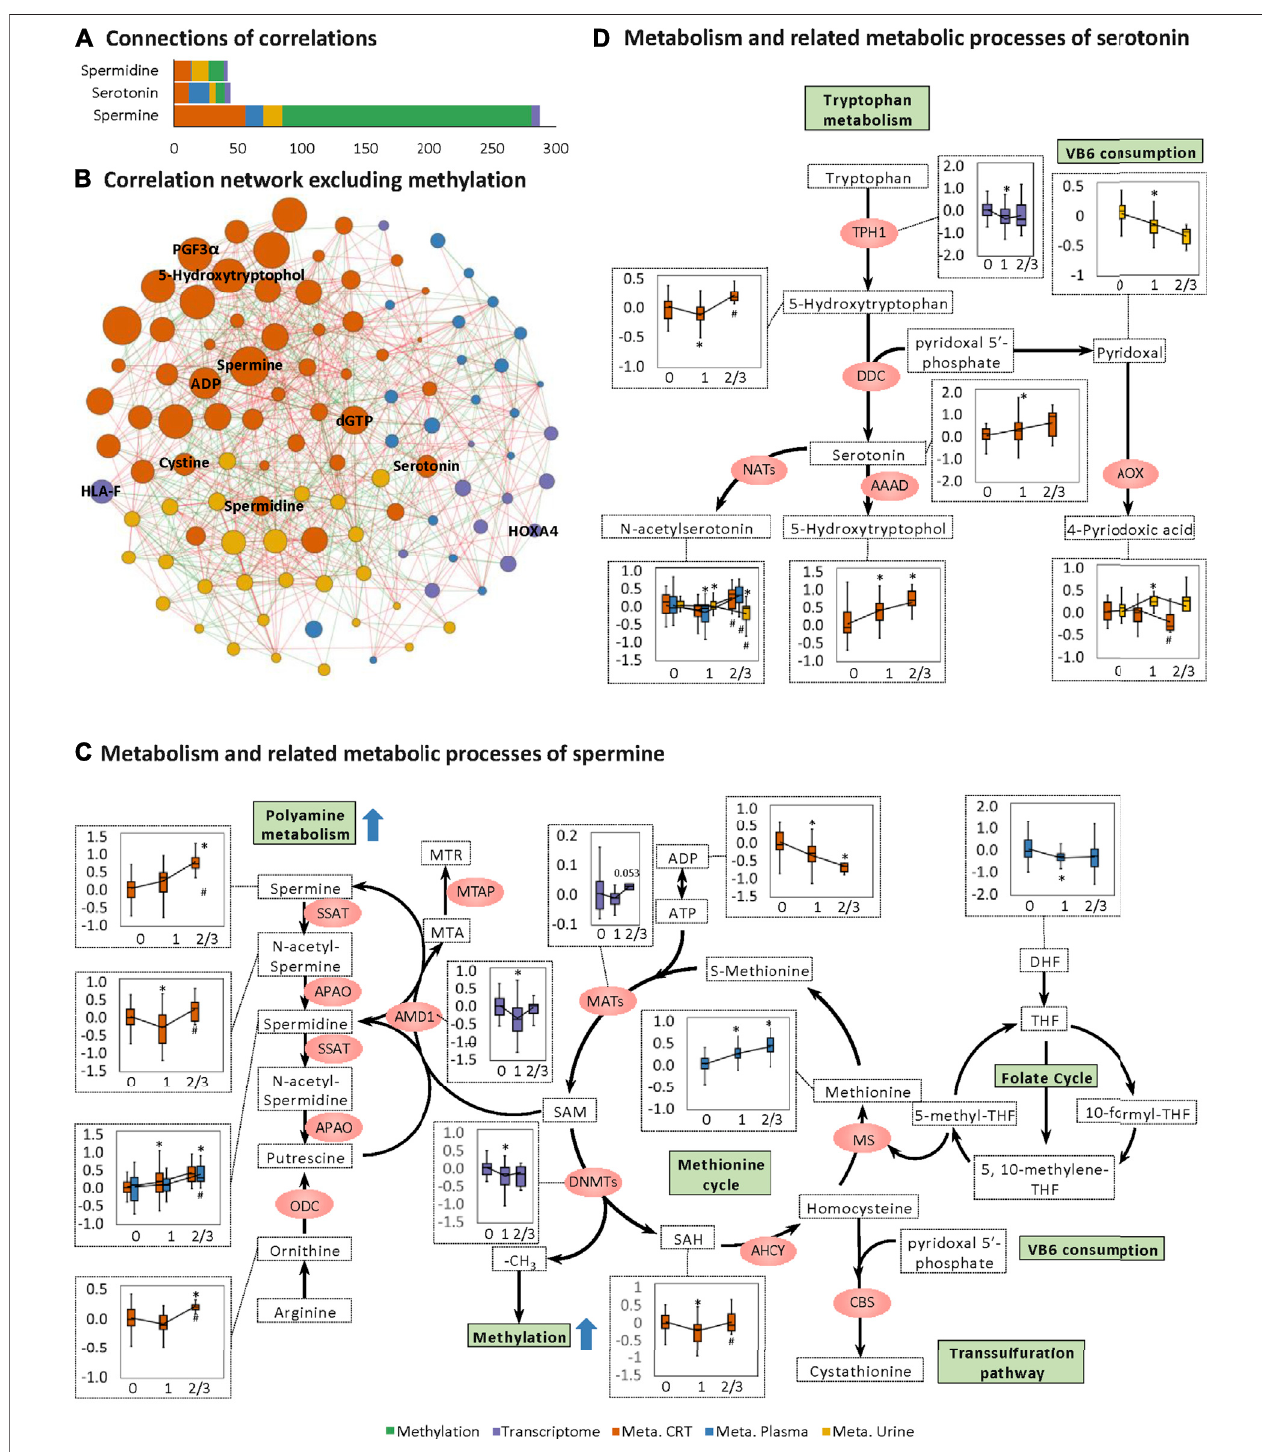
FIGURE 4 | ChangesinsperminemetabolismrelatedtoHFSsusceptibility. (A) Connectionsofcorrelations.Thestackedbarchartsshowtheconnectionsbetweendifferentially expressed features (DEFs) from all omics datasets with spermine, serotonin, and spermidine (selected based on MOFA LF1 weight and pathway enrichment analysis). (B) Correlation network with spermine, serotonin, and spermidine, excluding DNA methylation. A spermine-spermidine-serotonin metabolite-gene correlation network was constructed. The network includedonlypairedDEFswithsigni fi cantcorrelations(Spearmancorrelation, p < 0.05)inallomicsdatasets,excludingDNAmethylation.TherelativelyimportantDEFsarelabeled with feature names. Visualization was achieved with Gephi software (v0.9.2). Node colors represent the type of omics, and node sizes represent the strength of connections between features.Rededgesrepresentpositivecorrelations,andgreenedgesrepresentnegativecorrelations. (C,D) Metabolismandrelatedmetabolicprocessesofspermine (C) andserotonin (D) . Boxplotsshow therelative expression levels oftherelevantDEFs in groups HFS0, HFS1, and HFS2/3 (from left to right). Statisticalsigni fi cance wasset as: * p < 0.05for HFS1vs HFS0, HFS2/3 vs HFS0; # p < − 0.05 for HFS2/3 vs HFS1 by differential expression analysis using limma.